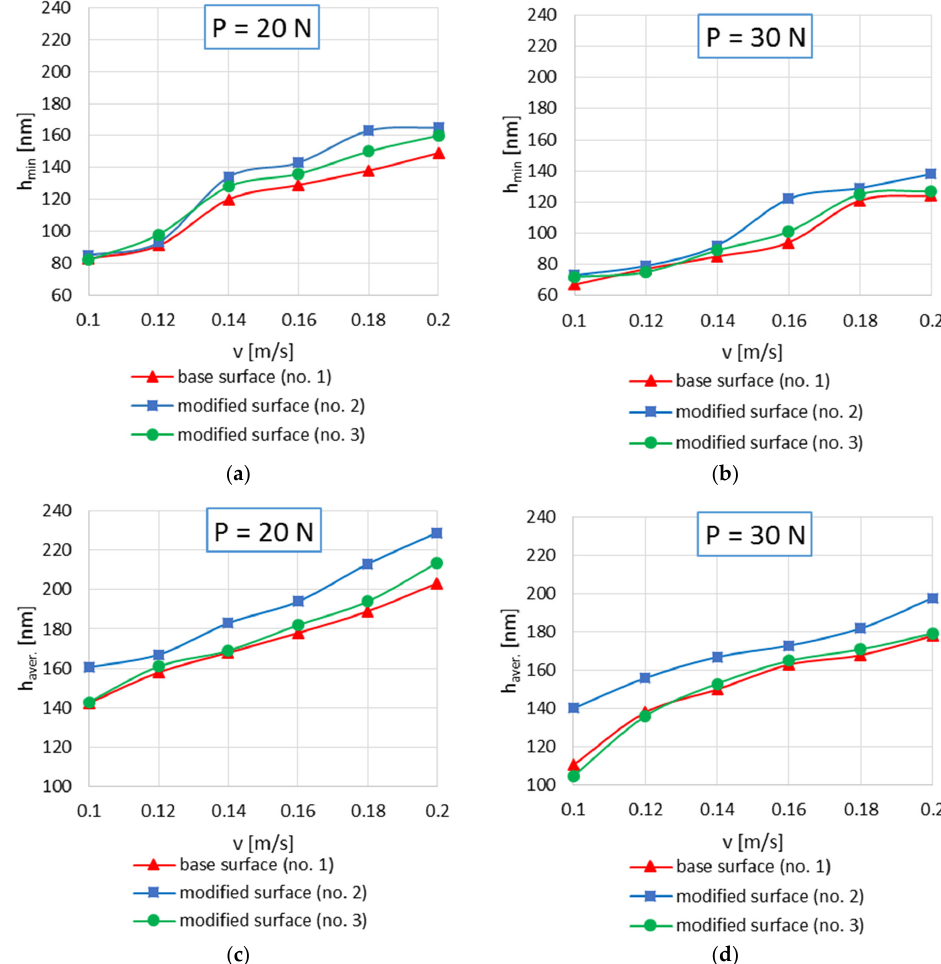
Figure 13. Minimum oil film thickness h min and average oil film thickness h aver. values in non-conformal sliding contact with loads of 20 N ( a , c ) and 30 N ( b , d ).